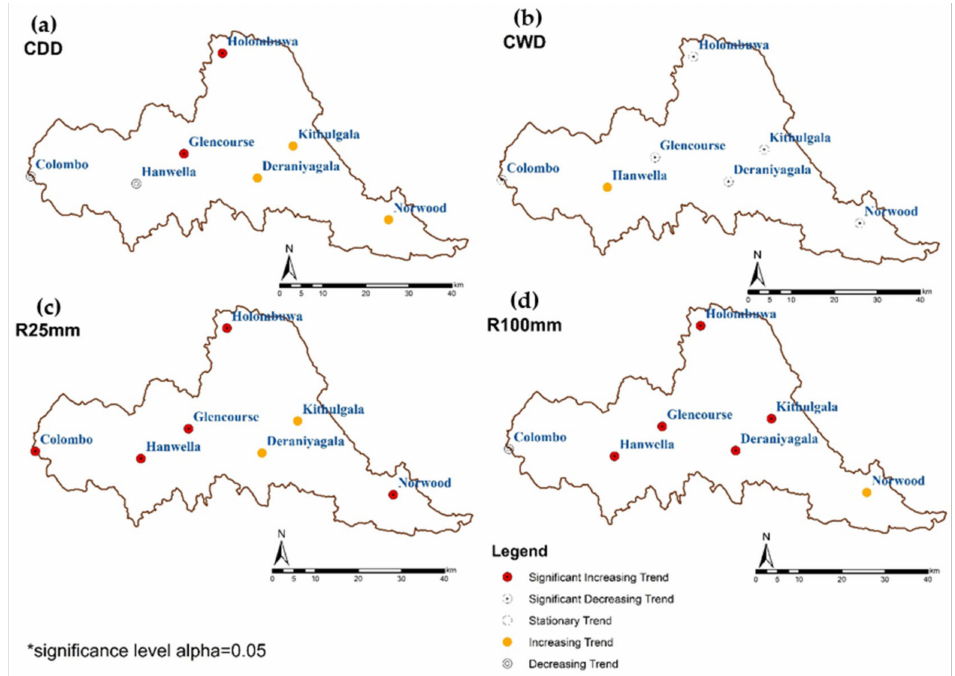
Figure 8. The spatial and temporal variability of the trend of fixed threshold EPIs in the last 40 years period in the study area: ( a ) CDD, ( b ) CWD, ( c ) R25mm, and ( d )